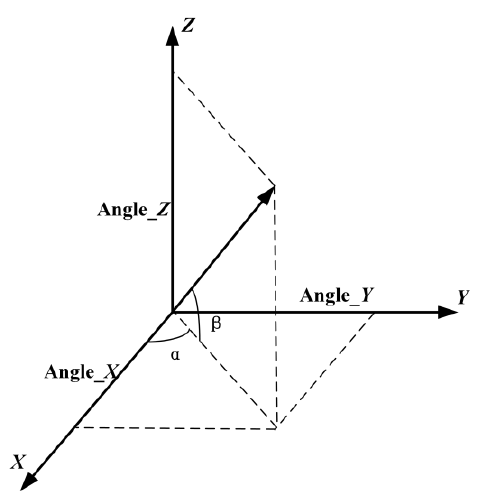
Figure 7. Relationship between laser angle direction and three-axis